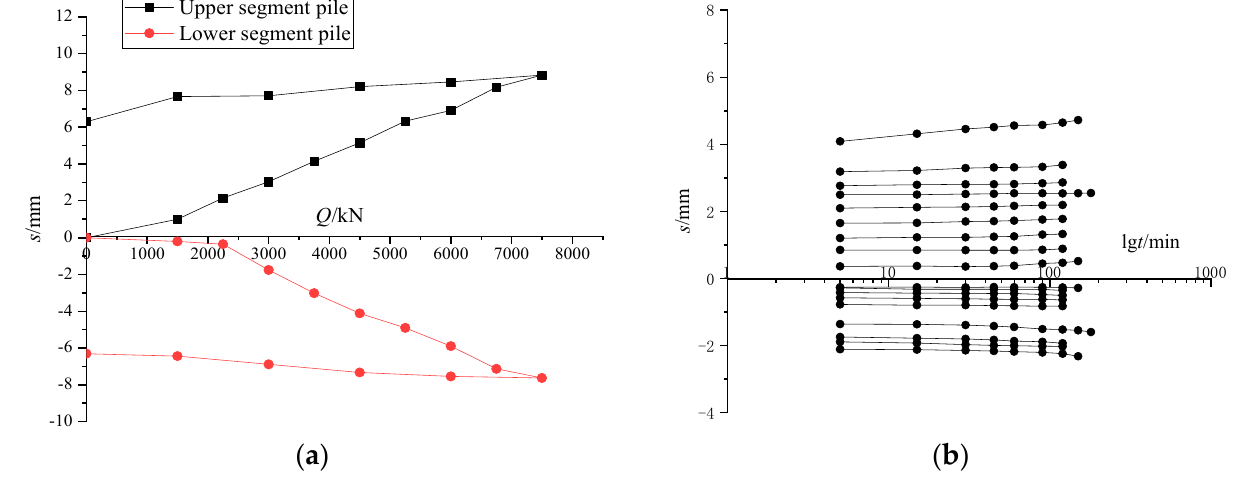
Figure 14. The result of the self-balanced method. ( a ) The Q-s curve. ( b ) The s-lgt curve.